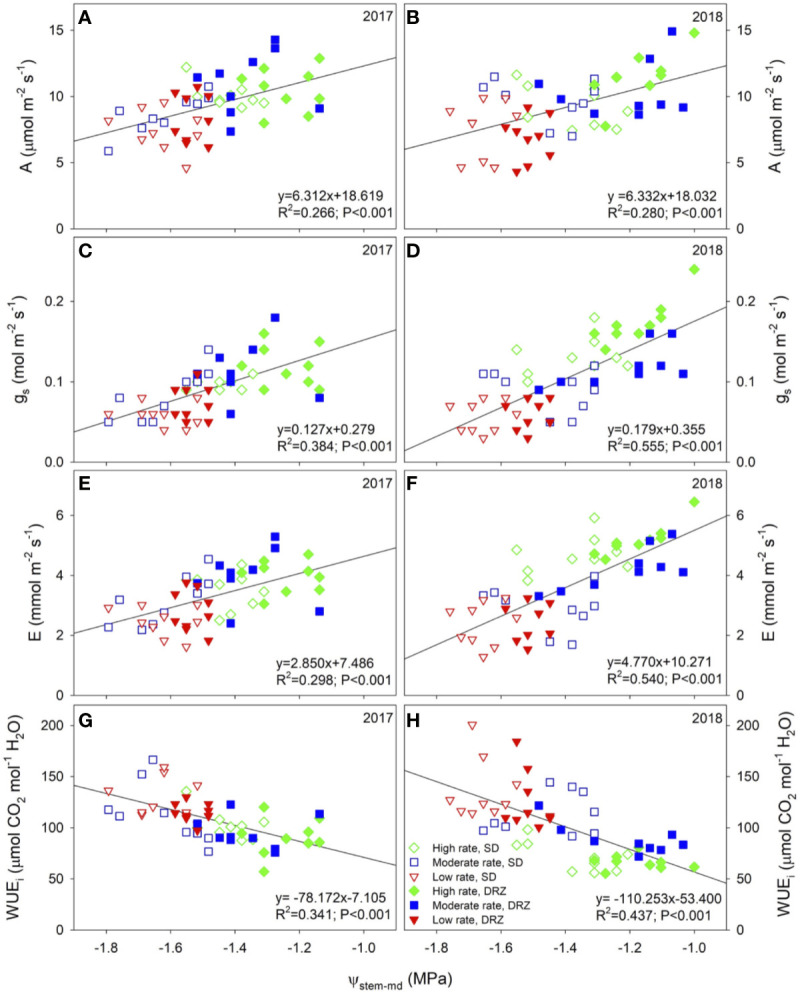
Linear correlations between leaf gas exchange and midday stem water potential (Ψstem-md, MPa) in 2017 and 2018. Positive correlations were found between (A, B) Ψstem-md and net CO2 assimilation rate (A, µmol m−2 s−1), (C, D) Ψstem-md and stomatal conductance (gs, mol m−2 s−1), and (E, F) Ψstem-md and transpiration rate (E, mmol m−2 s−1). Negative correlation was found between (G, H) Ψstem-md and intrinsic water use efficiency (WUEi, µmol CO2 mol−1 H2O). Open symbols represent the surface drip irrigation (SD), and closed symbols represent the direct root-zone irrigation (DRZ). Three irrigation rates were set based on crop evapotranspiration (ETc) for Cabernet Sauvignon: Green diamonds, blue squares, and red triangles represent irrigation rates at high (0.75–0.80 ETc), moderate (0.60–0.65 ETc) and low (0.45–0.50 ETc), respectively. R2: coefficient of determination. Data were from measurements on Day of the year 258 and 257, respectively in 2017 and 2018 and were pooled within each year (n = 54).